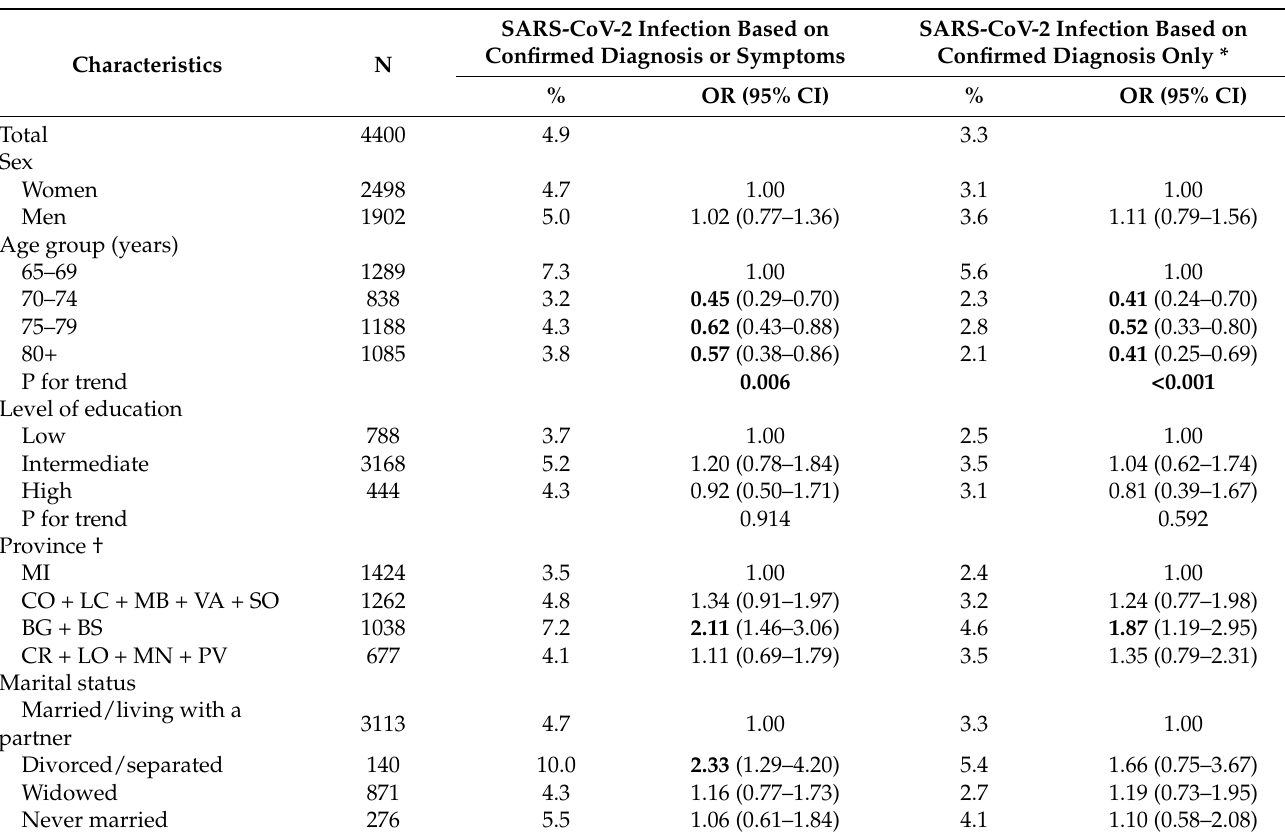
Table 1. Distribution of 4400 Italian subjects aged 65 years or above according to SARS-CoV-2 infec- tion, overall and by selected characteristics. Corresponding odds ratios ˆ (OR) and 95% confidence intervals (CI). Lombardy region, Italy, 2020.